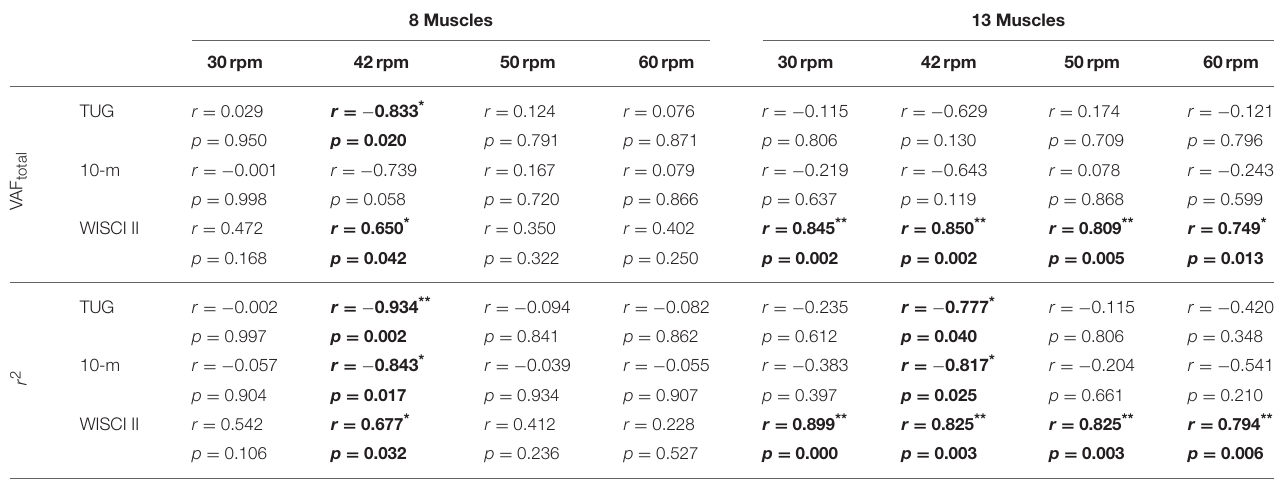
TABLE 5 | Correlation of gait scales (from iSCI patients) with VAF total and r 2 results of the EMG reconstruction with 8 and 13 muscles, for all speeds. 8 Muscles